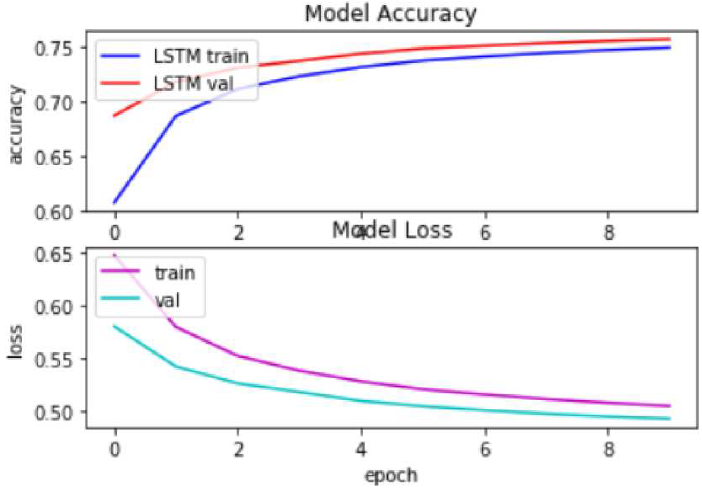
Fig. 11 Experimental results of Bi-LSTM sentiment